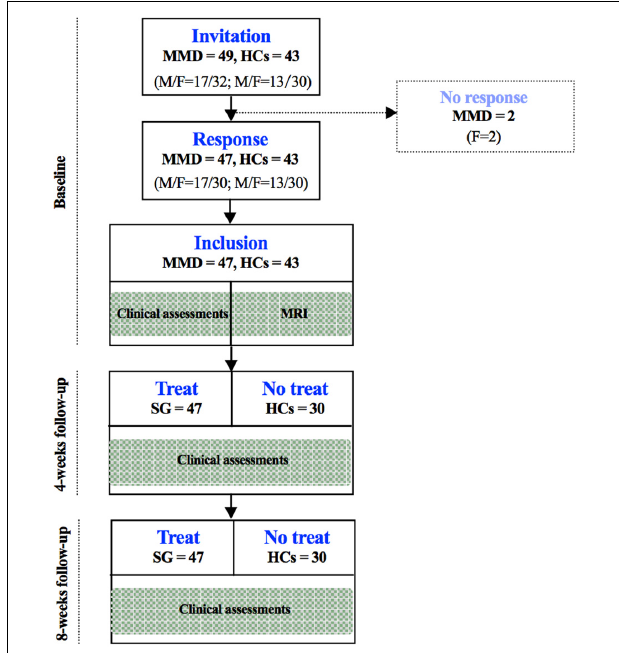
FIGURE 1 | Flow chart of the participant enrollment and follow-up in this study. SG, Shugan Jieyu Capsule; HCs, healthy controls.